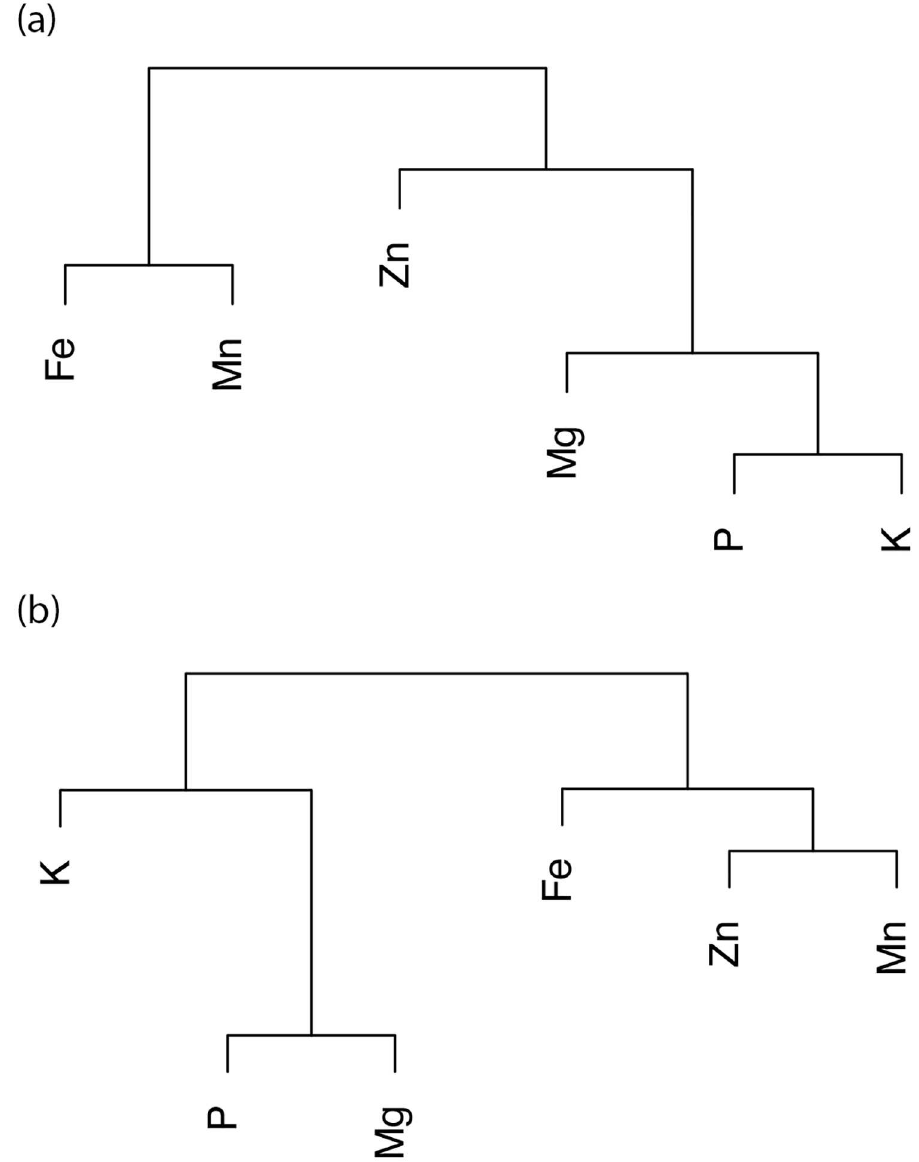
Fig 4. Unweighted Pair Group Method with Arithmetic Mean cluster dendrogram based on genetic correlations in Japan (a) and Afghanistan